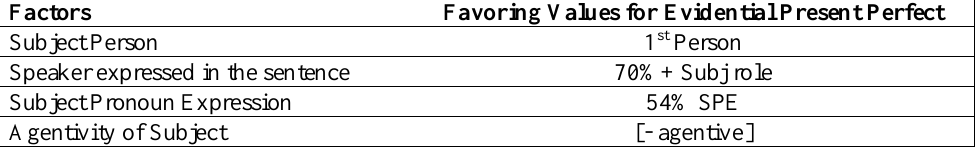
Table 4. Factors favoring the Present Perfect grammaticalization process